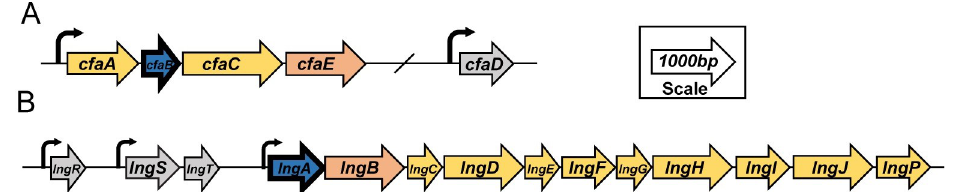
Fig 1. Schematic representation of the CFA/I and CS21 operons. The CFA/I (A) and the CS21 operons (B) are depicted with arrows indicating coding sequences and lines representing intergenic regions. The size of the arrows represent relative size (bp) of genes. The bolded subunits (blue) represent the major subunit of the operon. Curved arrows indicate a putative promoter.